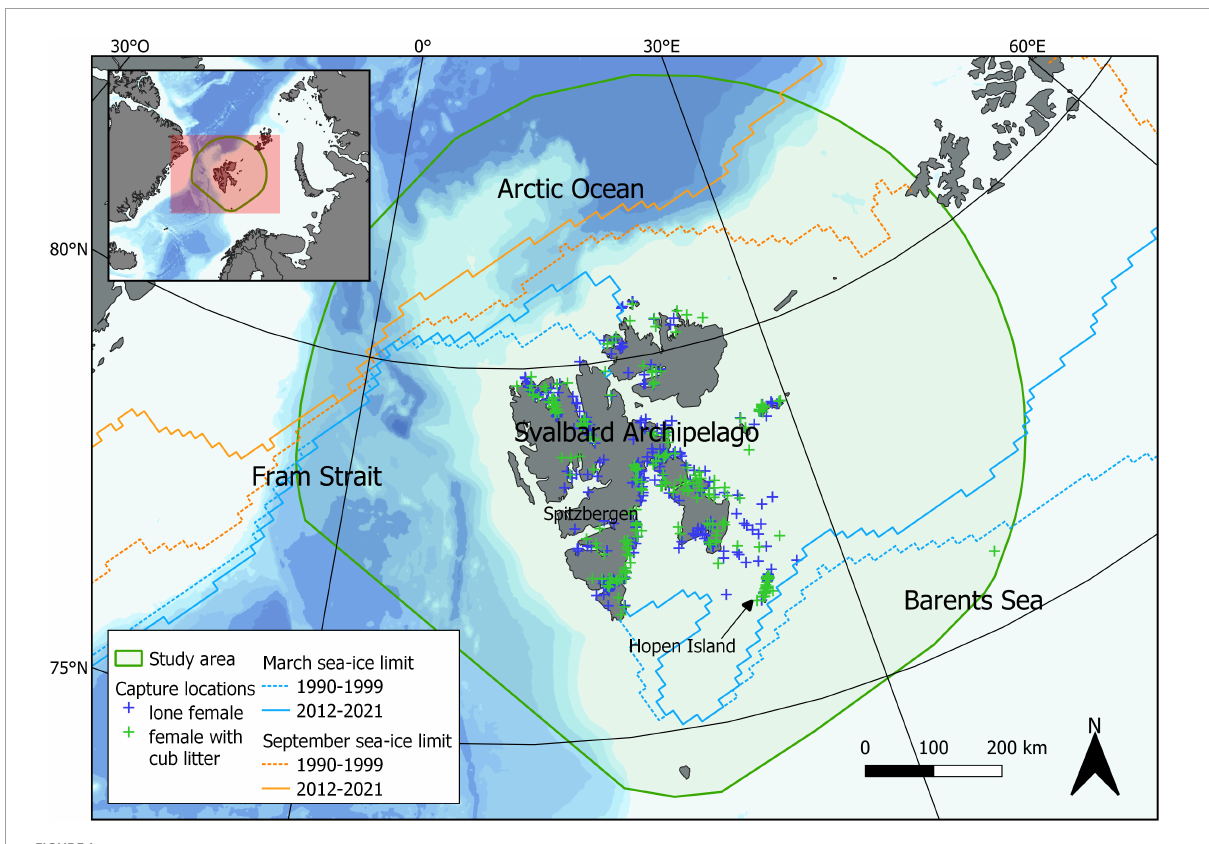
FIGURE1 Capture locations of adult female polar bears in the Svalbard area from 1992 to 2019 and 2021 to 2022. Captures of lone females from 1992 to 1999 were excluded from our analysis and are not represented. The lines represent the mean maximum (March) and minimum (September) sea-ice extents for the periods 1990–1999 and 2012–2021. The study area corresponds to the 95% minimum convex polygon of telemetry locations of 135 adult females recorded between 1989 and